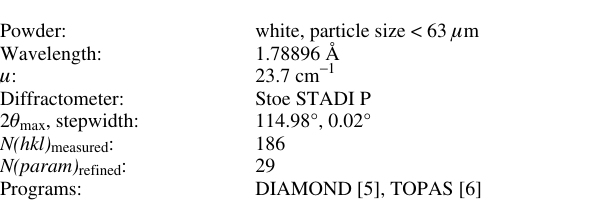
Table 3. Data collection and handling. Table 4. Atomic coordinates and displacement parameters (in Å 2 ) .